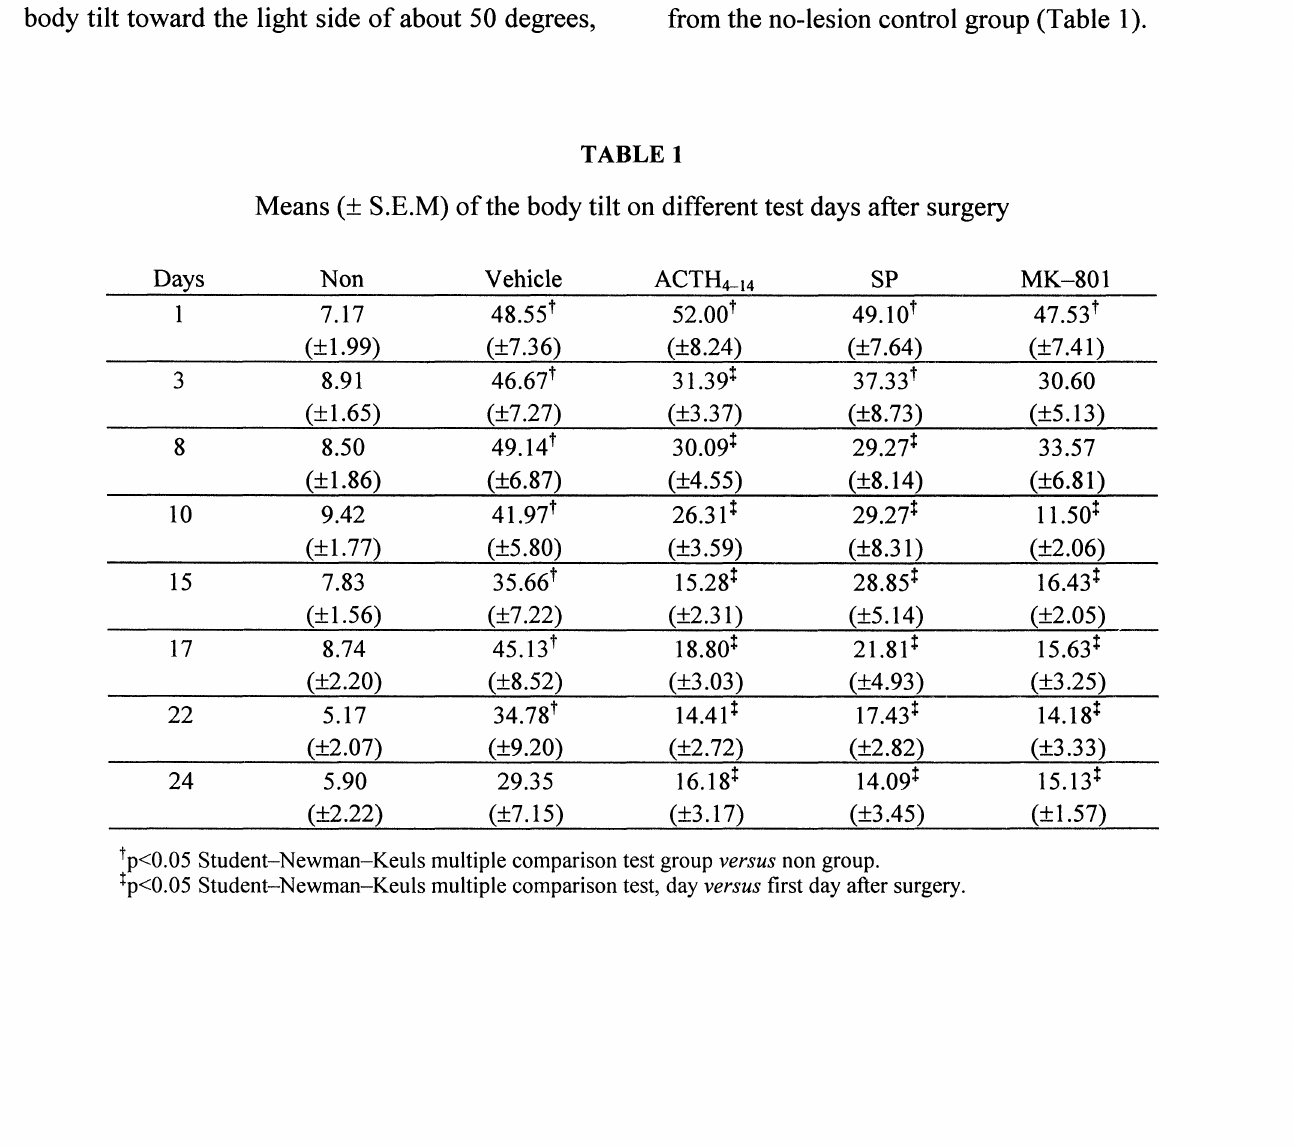
Means (+ S.E.M) of the body tilt on different test days after